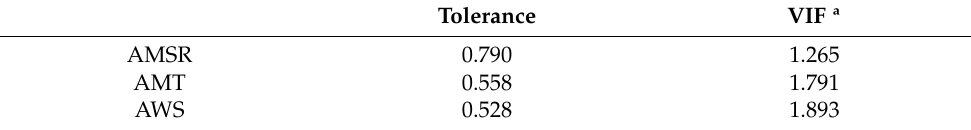
Table 6. Co-linearity analysis of spatial properties variables